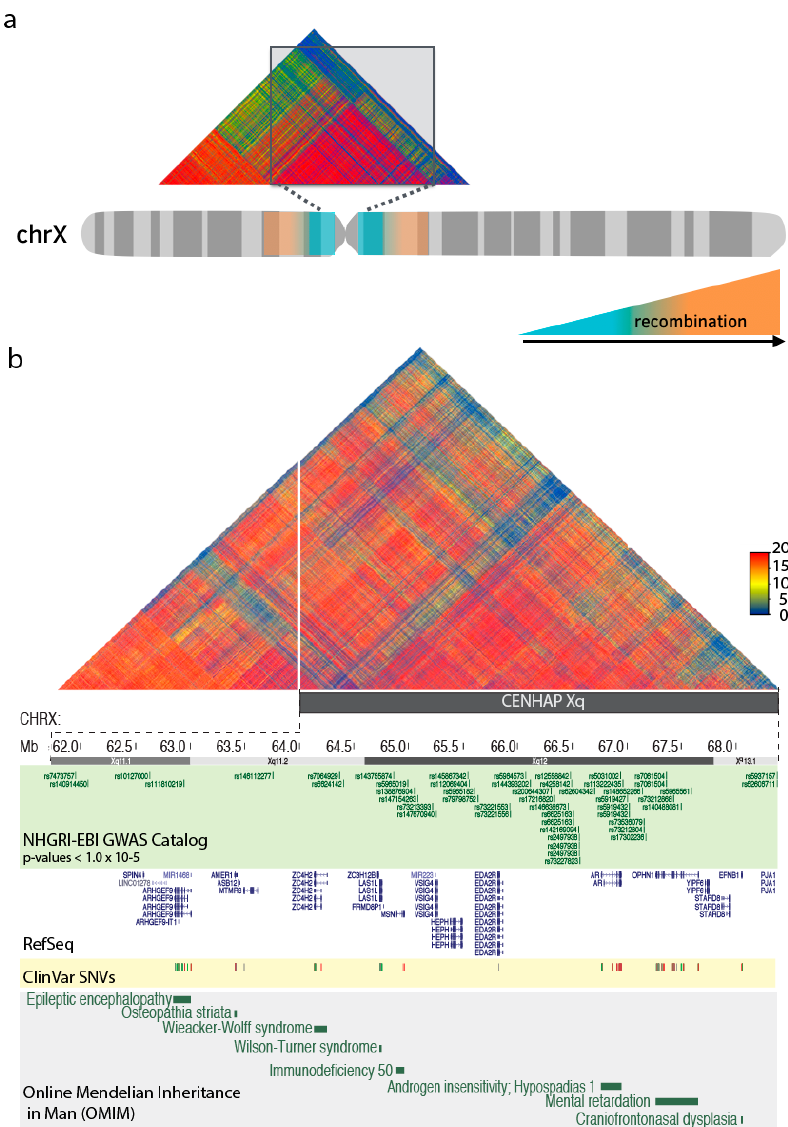
Figure 3. Disease-associated variants in centromere-associated haplotypes. (a) Centromeres act as the primary constriction of chromosomes, and are historically defined by the reduction of meiotic recombination (indicated by blue). Therefore, sequences in these regions are commonly inherited in large linkage blocks, or cenhaps (shown in the linkage disequilibrium heat map) [70]. (b) Study of disease and clinically associated single nucleotide variants (GWAS Catalog (green), ClinVar SNVs (yellow) in the Xq cenhap region (with Linkage Disequilibrium heat map from (a) enlarged) and a collection of annotated genes (RefSeq, white), of which variation have been attributed to a human disease (OMIM data, grey).